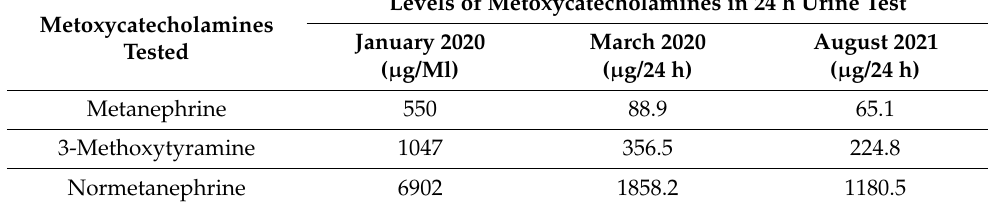
Table 1. Changes in clinical findings with